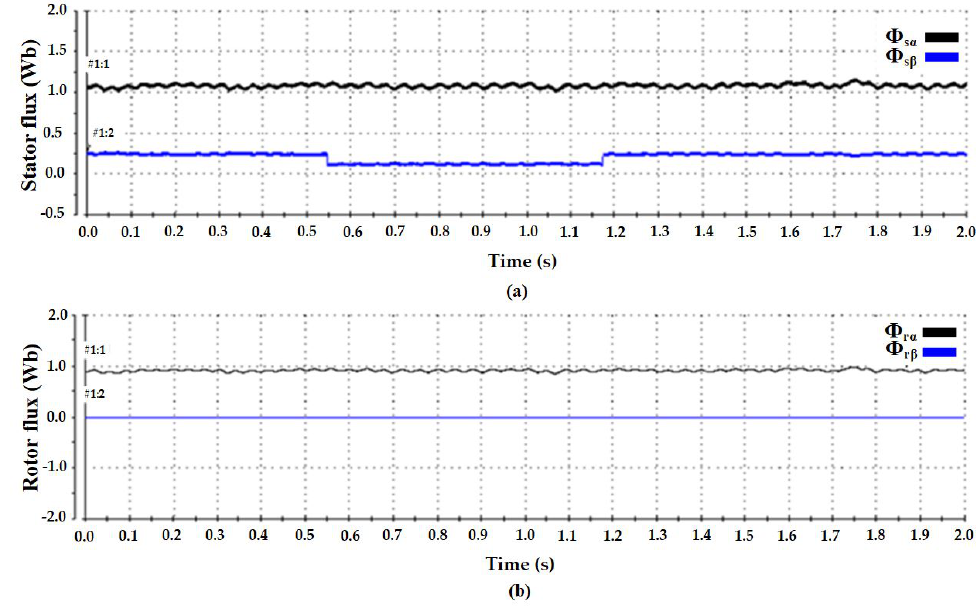
Figure 27. Flux at high speed (75% ω n ): ( a ) Stator flux components, ( b ) Rotor flux